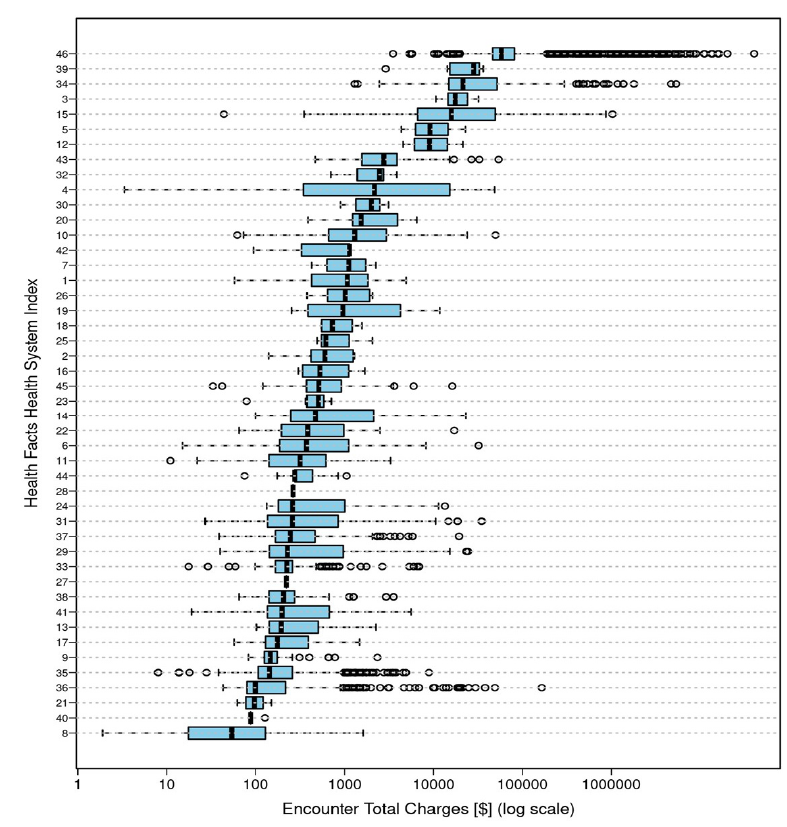
Figure 2. Distribution of total encounter costs across healthcare systems.